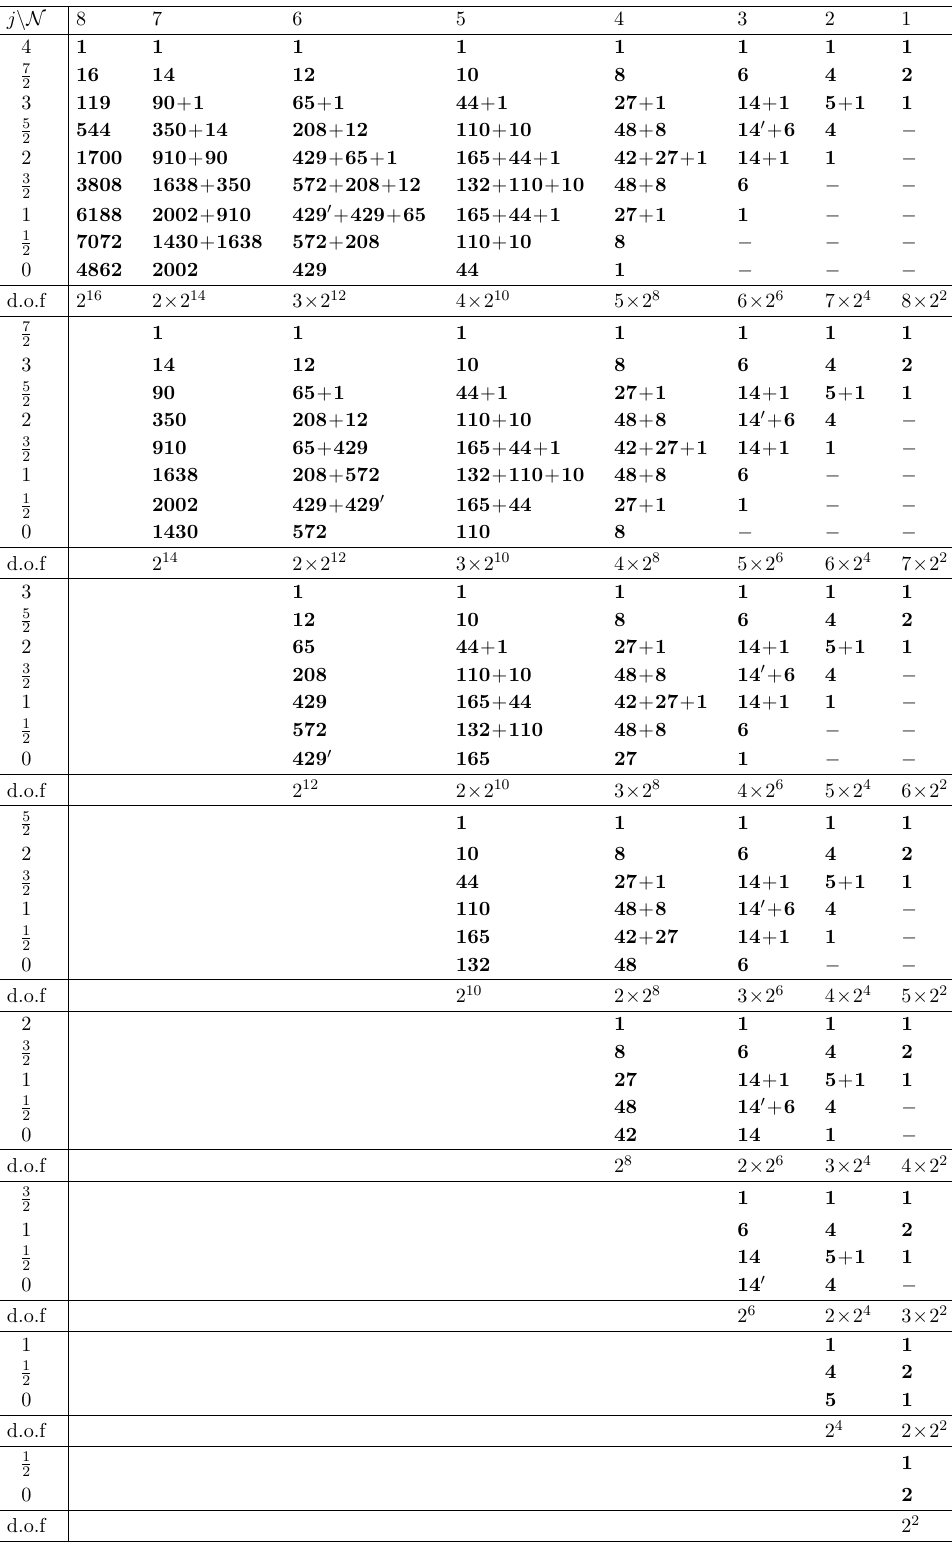
Table 2 . The long massive N -extended spin-( j max ) multiplets for 1 = 2 (cid:20) j max (cid:20) 4 and 1 (cid:20) N (cid:20) 8. The states are labelled by Spin(3) (cid:2) Sp( N )